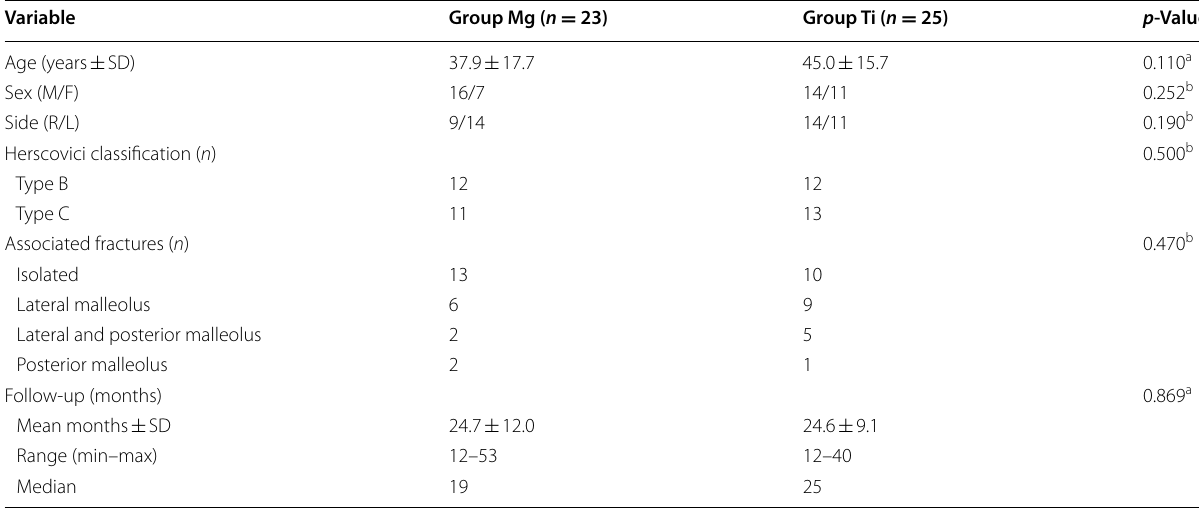
Table 1 Demographic and clinical characteristics of